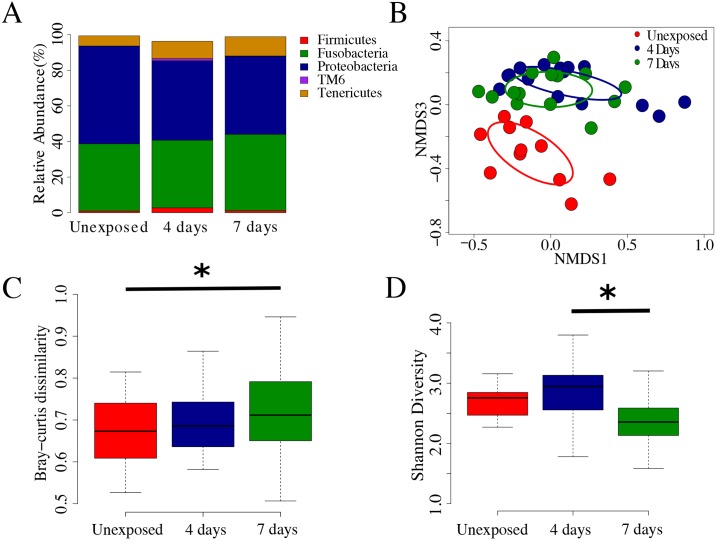
Triclosan exposure is associated with altered microbial community structure.(A) Phyla level taxa plot of the most abundant taxa in zebrafish gut microbiomes across exposure groups. (B) Non-metric multidimensional scaling analysis of unexposed (red dots), four-day (blue dots) and seven-day (green dots) exposure group’s microbial communities. Colored ellipses represent the 99.9% confidence interval for standard error of each group. (C) Comparisons of within group Bray-Curtis dissimilarity between groups. (D) Shannon entropy between exposure groups. Significant p-values (p < 0.05) are denoted with an asterisk.